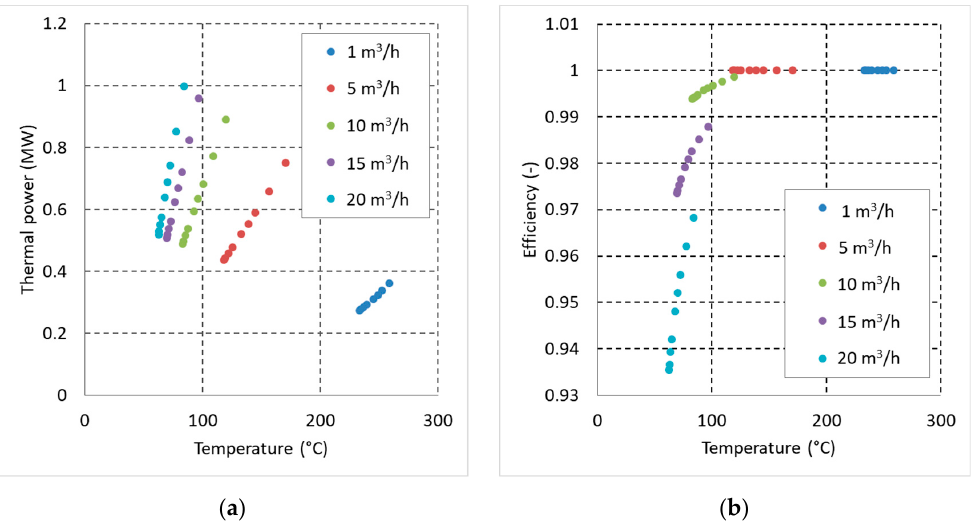
Figure 5. Results for the DBHE. ( a ) Thermal power vs outlet temperature and ( b ) efficiency vs outlet temperature.